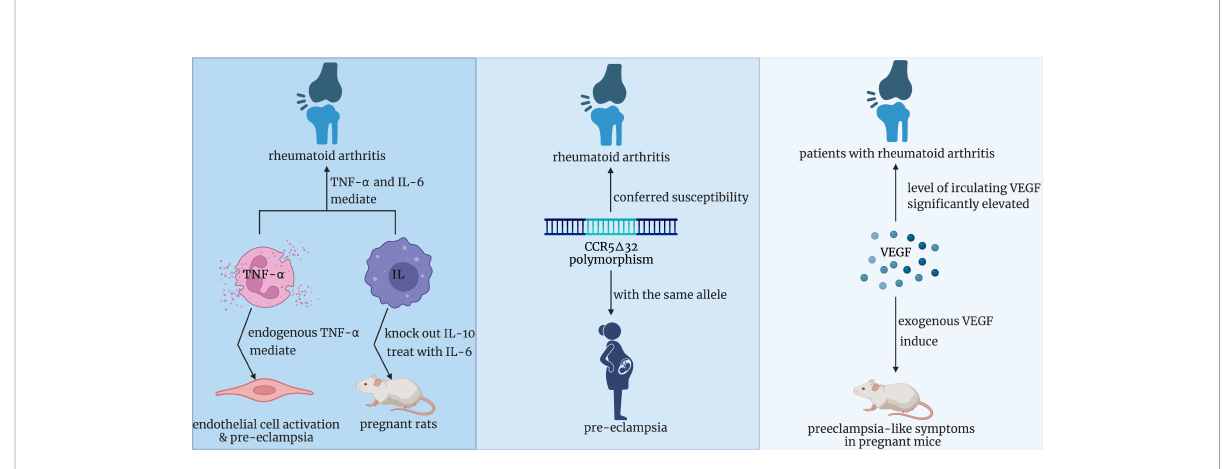
FIGURE 6 Three potential underlying mechanisms of the positive correlation between RA and pre-eclampsia. RA, rheumatoid arthritis.